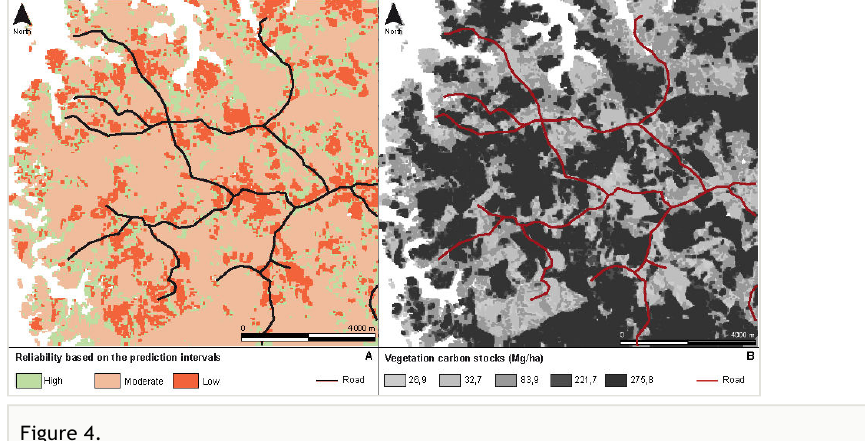
Figure 4. Prediction intervals around the predicted vegetation carbon stock in